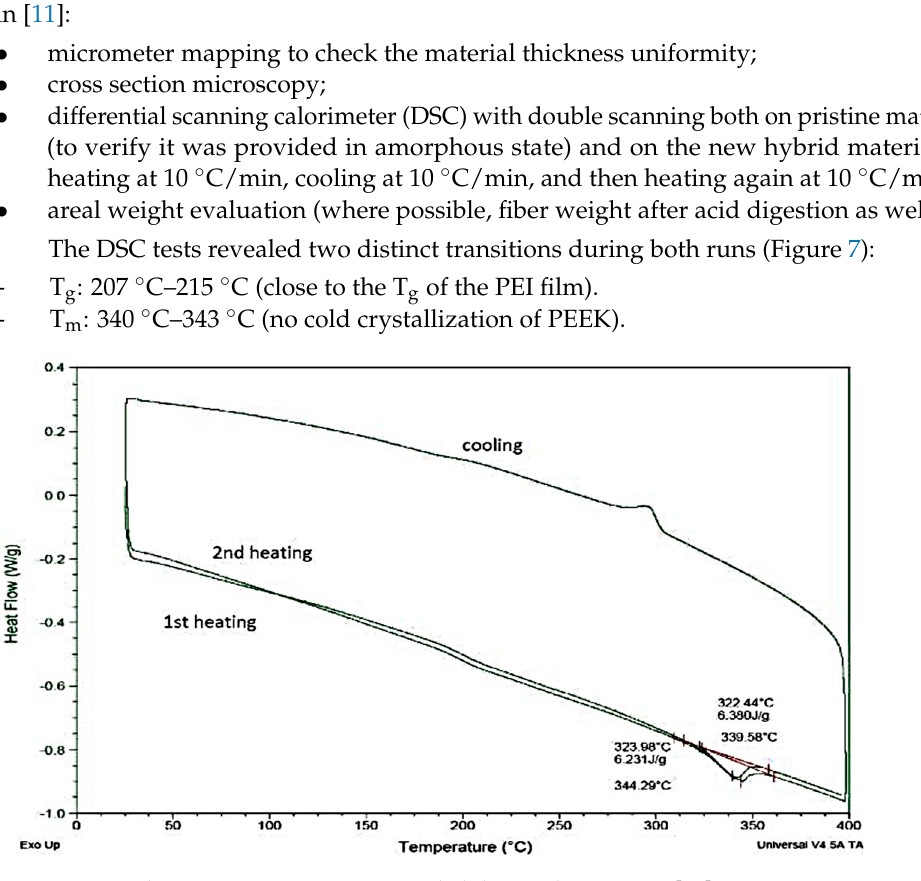
Table 1. ILSS results for both material versions tested.